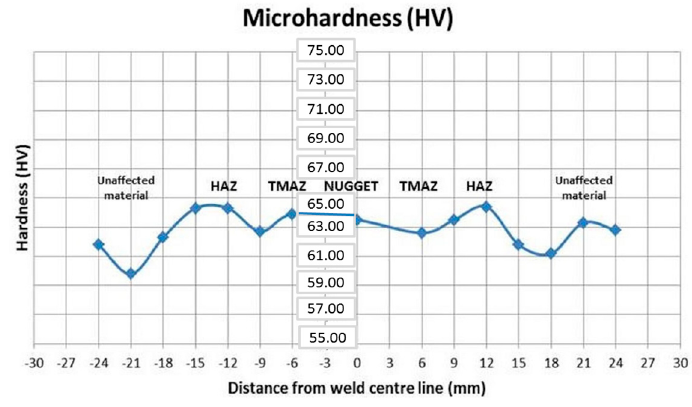
Figure 12. Micro hardness distribution of a significant test.